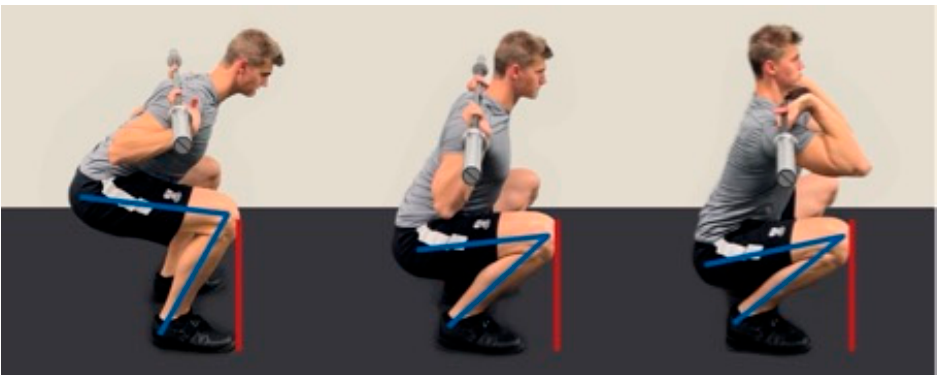
Figure 2. Squat variations and AKD: Low-bar back squat (LBBS, left ), deep high-bar back squat (DHBBS, center ), and deep front squat (DFS, right ). AKD (red lines) and knee angle (formed by the lines in blue) vary between different barbell squat